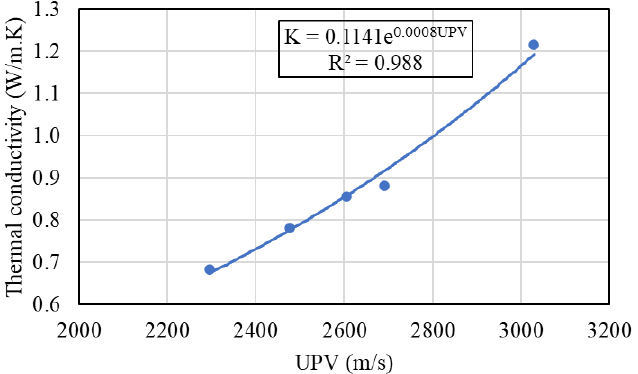
Figure 13. Relationship between UPV and thermal conductivity of geopolymer mortar containing BLWA.